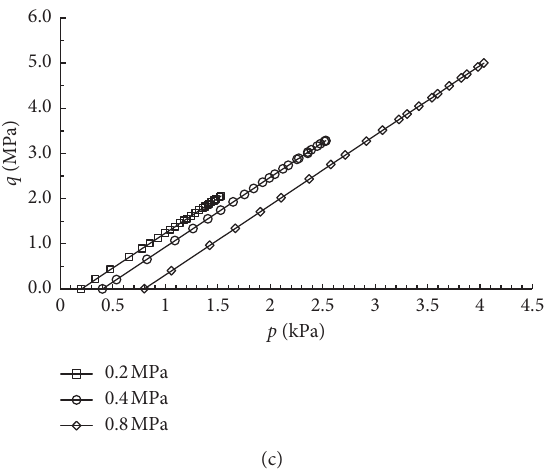
Figure 9: Comparison on the constant σ